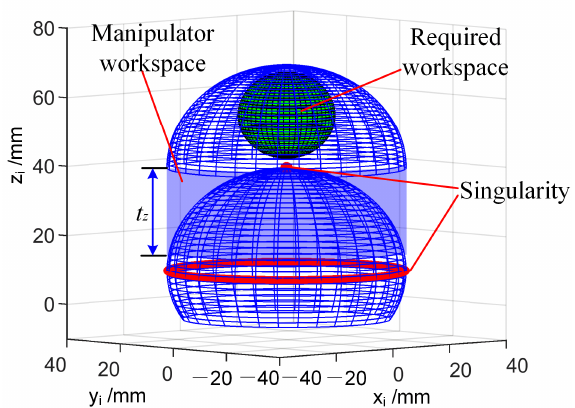
Figure 7. The singularity and workspace of the manipulator.